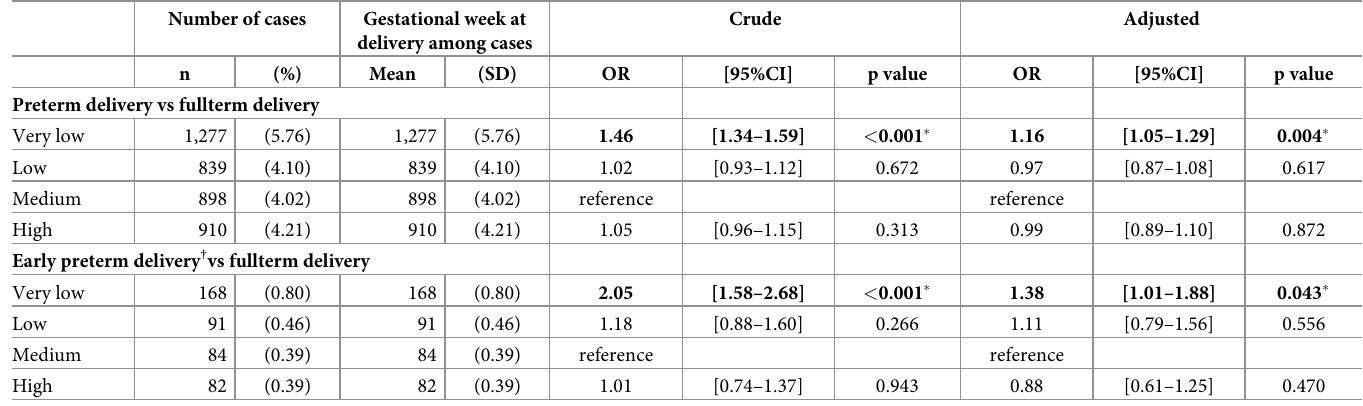
Table 3. Association between physical activity level during pregnancy and preterm